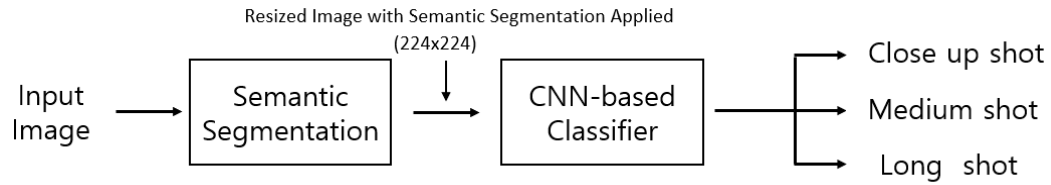
Figure 8. Structure of the suggested semantic segmentation.